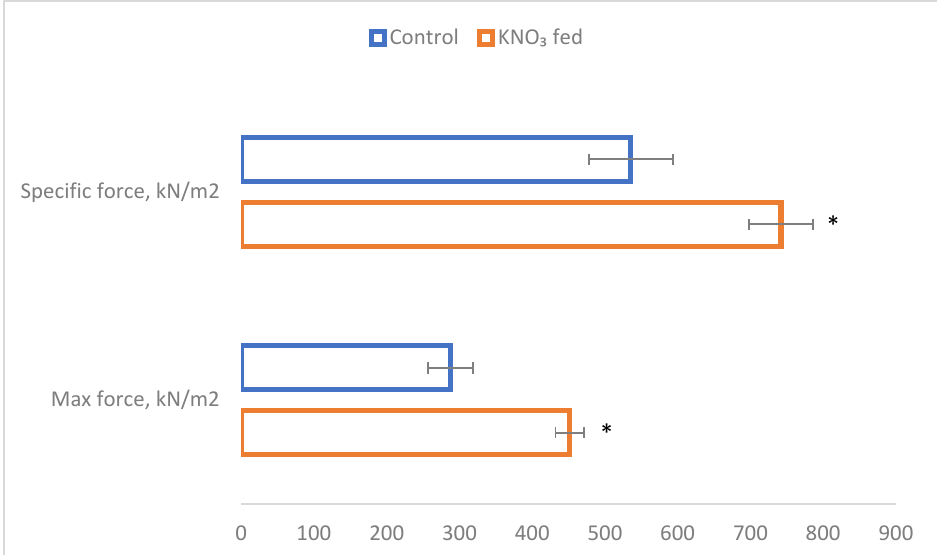
Figure 1. The specific and maximum force of EDL muscles of control and KNO 3 -fed mice. Significant differences are indicated by asterisks